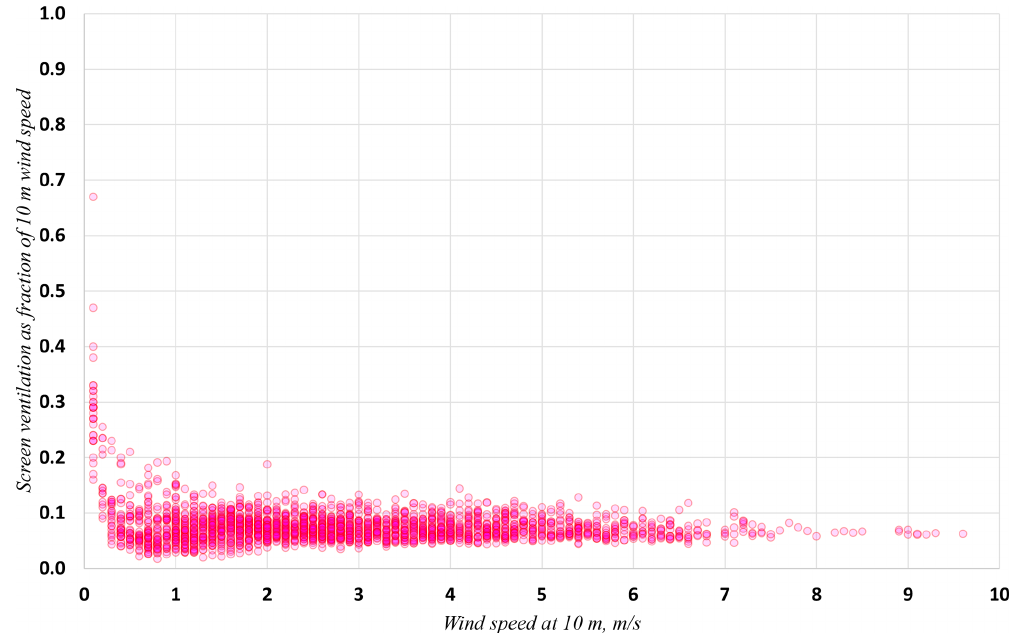
Figure 5. Scatterplot of U screen as a fraction of U 10 based on hourly scalar means. Above about 1ms − 1 ,U screen ≈ 7% of U 10 .